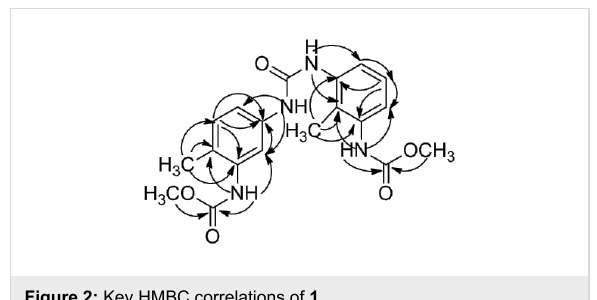
Figure 2: Key HMBC correlations of 1 .